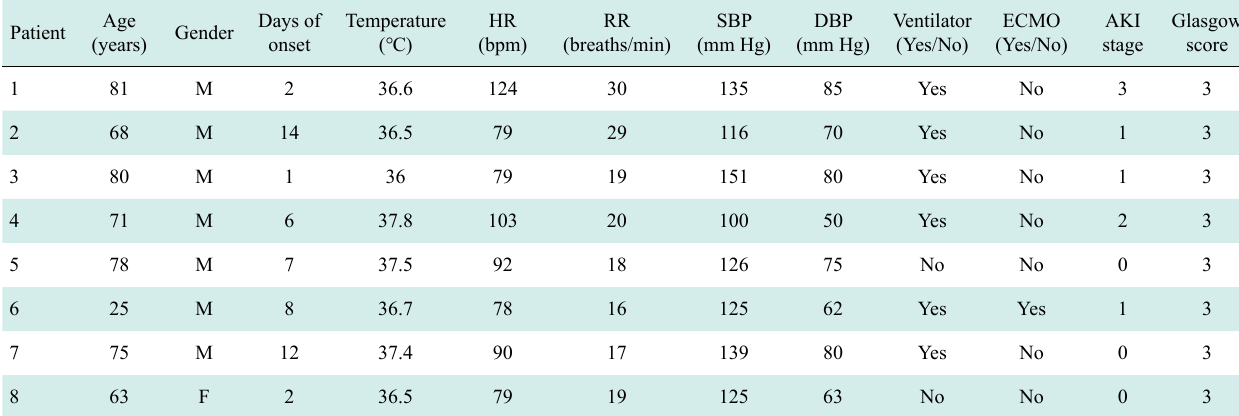
Table1 Demographics and baseline characteristics of patients infected with COVID-19